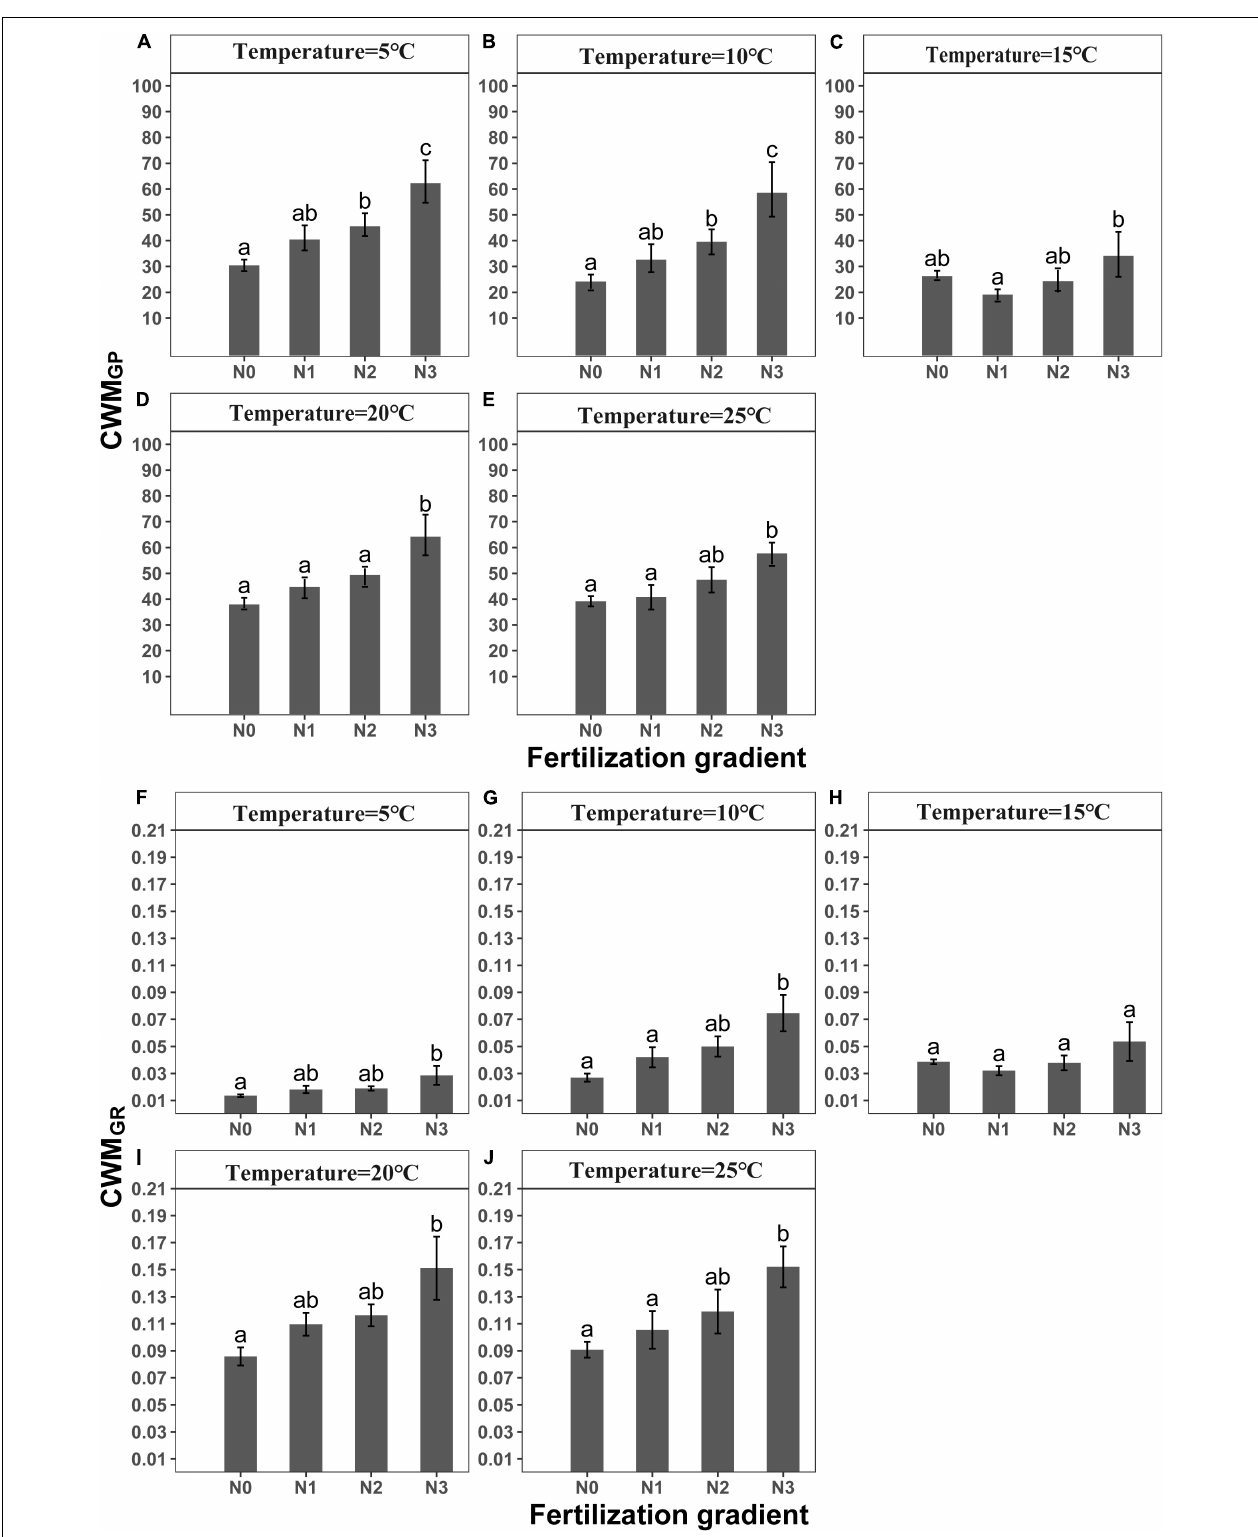
FIGURE 1 | Effects of temperature and level of nitrogen addition (N0, 0 g N m − 2 year − 1 ; N1, 5 g N m − 2 year − 1 ; N2, 10g N m − 2 year − 1 ; N3, 20g N m − 2 year − 1 ) on CWM GP (community weighted mean of germination percentage) and (A–E) CWM GR (community weighted mean of germination rate). (F–J) Different letters indicate significant differences in level of nitrogen addition ( P < 0.05) at each temperature. Error bars are ± SE.